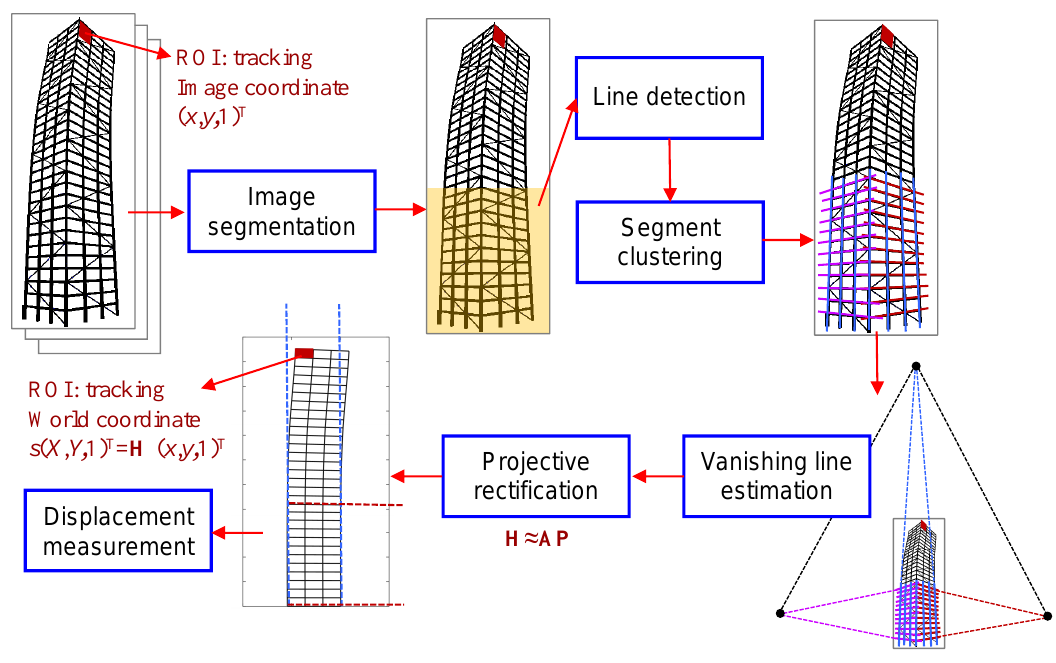
Figure 1. Overview of the proposed technique.